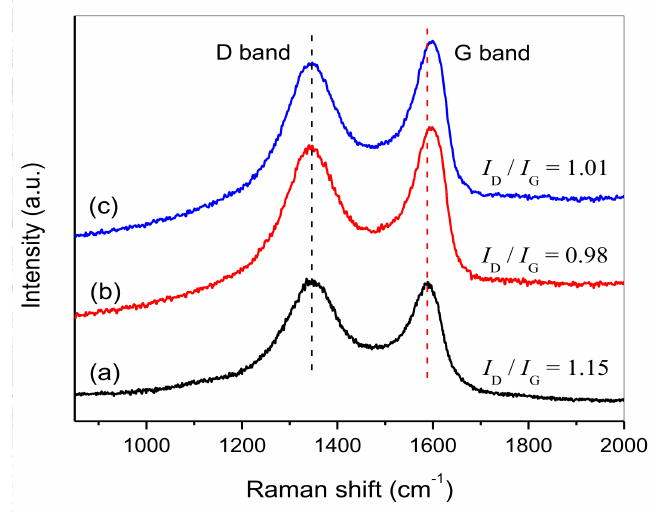
Figure 3. Raman spectra of (a) bare GO, (b) HTT/graphene-1.0%, and (c) HTT/graphene-4.0%